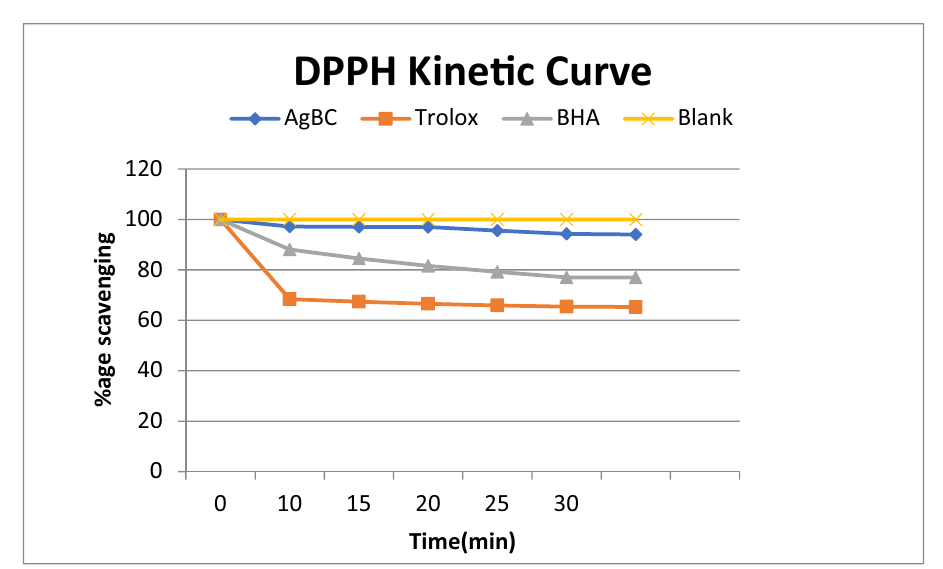
Figure 9. DPPH kinetic curve of biosynthesized silver nanoparticles at different time intervals when TROLOX solution was used as positive